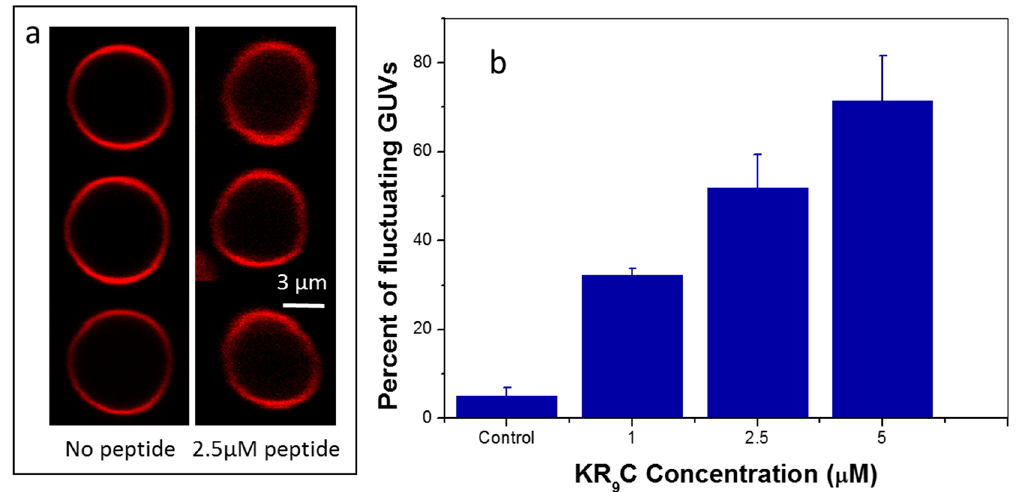
Figure 6. Shape fluctuations of GUVs composed of DOPC/DOPG. ( a ) Representative images. ( b ) Percent of fluctuating GUVs at each peptide concentration.